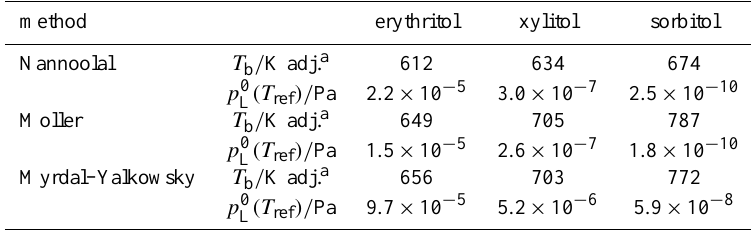
Table 9. p 0 calculations for erythritol, xylitol and sorbitol, with three vapour pressure estimation methods (Nannoolal et al., 2008; Moller L et al., 2008; Myrdal and Yalkowsky, 1997) available at